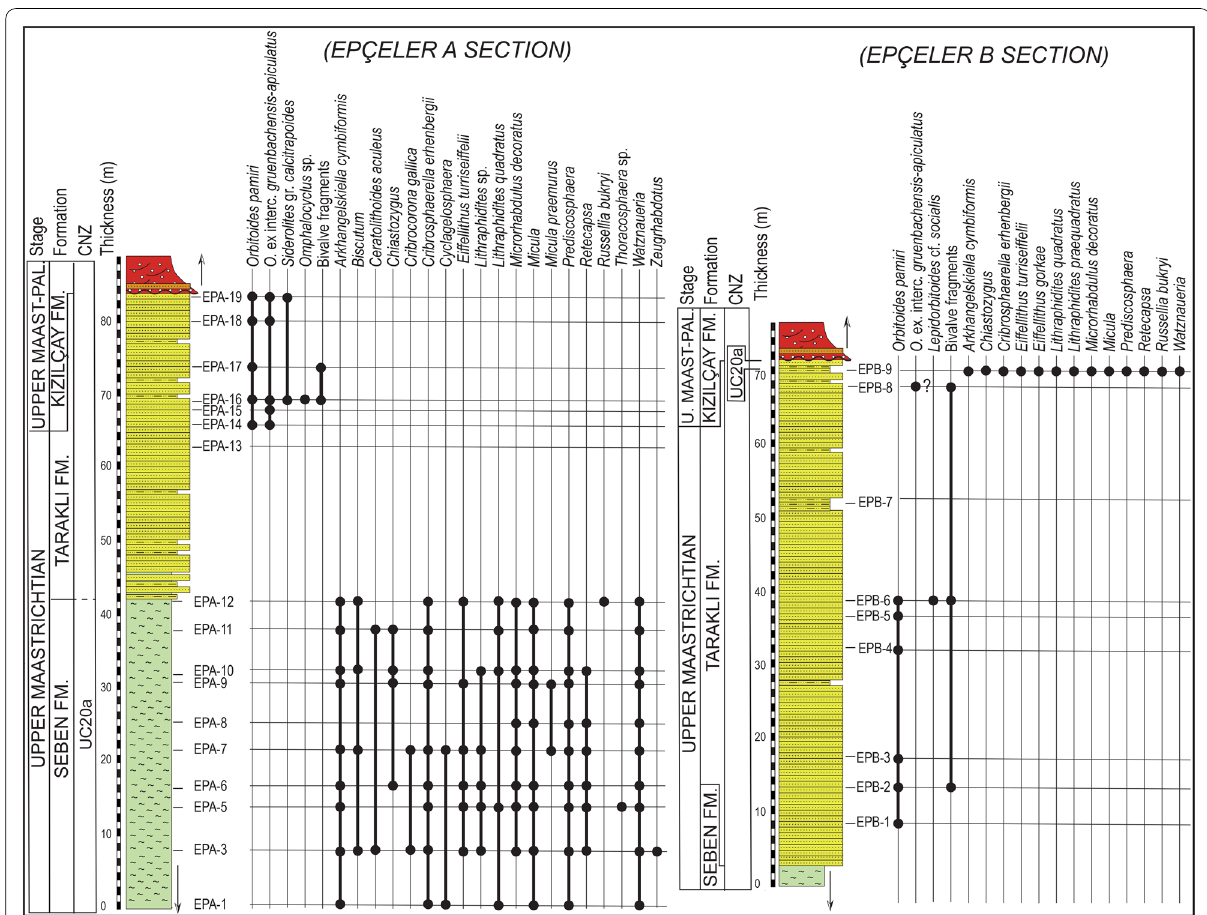
Fig. 3 Distribution of LBF, calcareous nannofossils and other fossils in the Taraklı Formation in Epçeler A and B